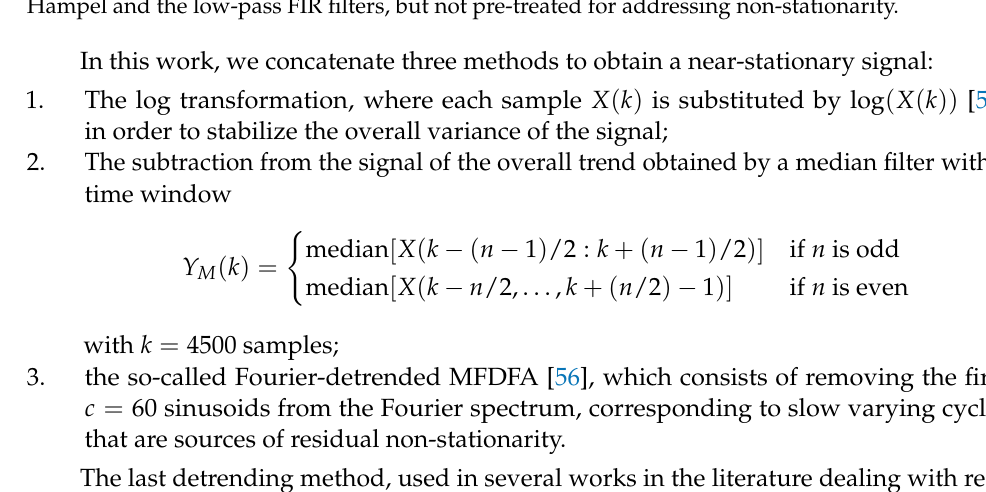
Figure 2. Scaling function F 2 ( s ) computed through the DFA3 for the BPd signal filtered with the Hampel and the low-pass FIR filters, but not pre-treated for addressing